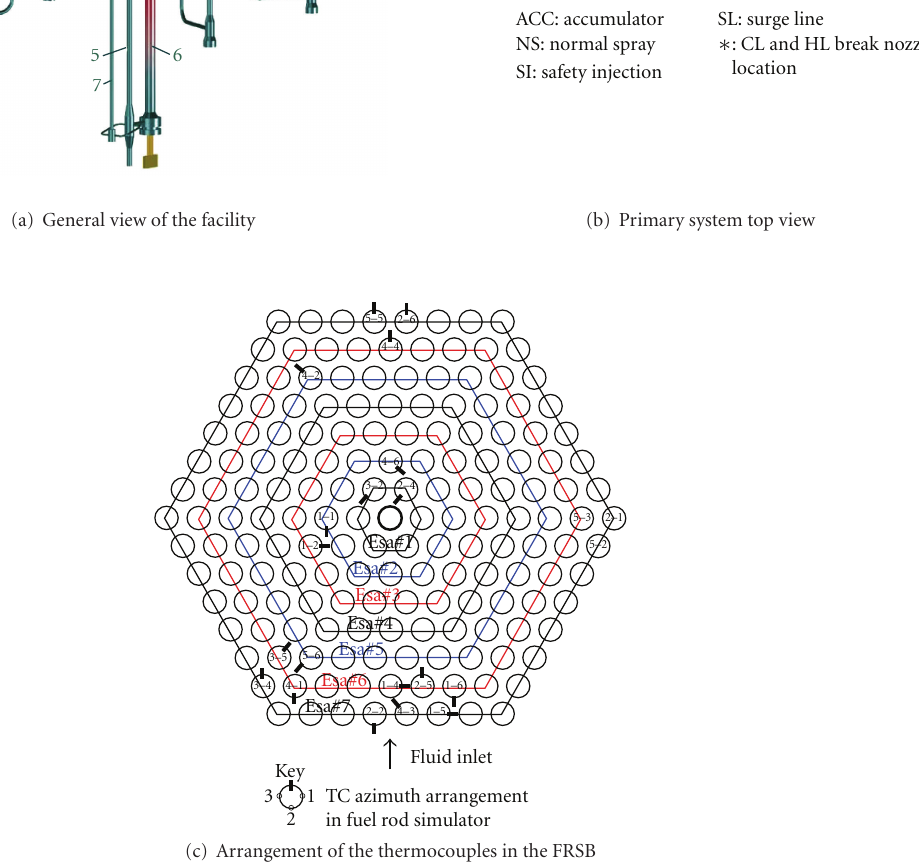
Figure 1: PSB-VVER facility installed at EREC